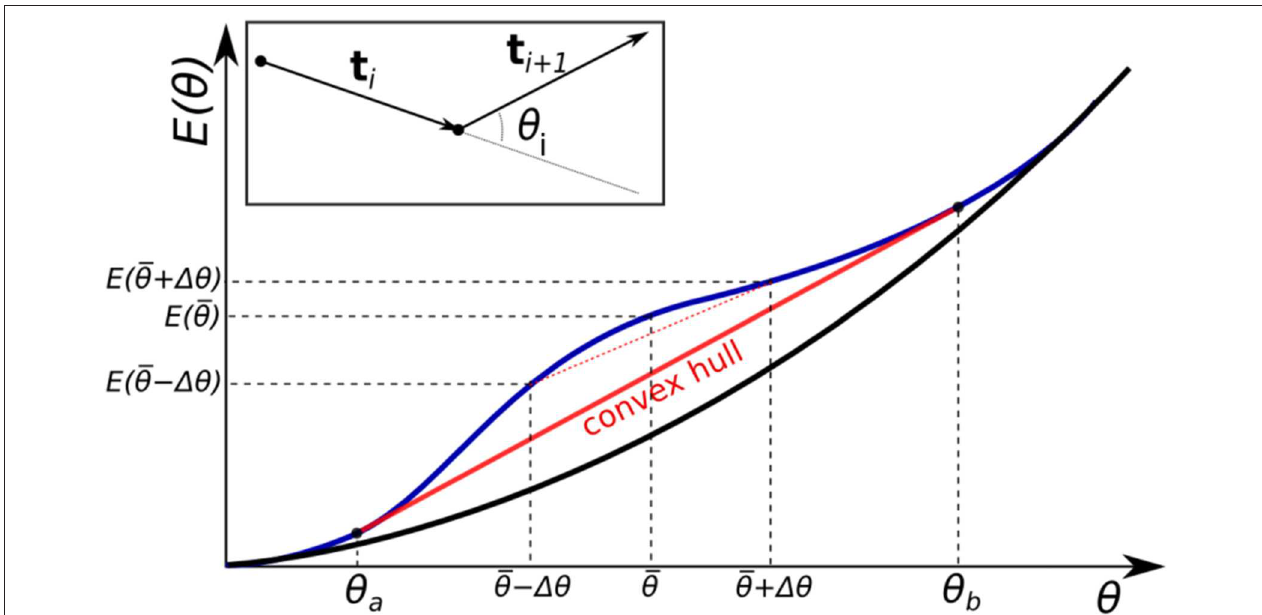
FIGURE 1 | Two different forms for a bending energy profile of a homopolymer. Shown is the (effective) bending energy per bending site E ( θ ). If the profile is purely convex down (black curve), the minimal energy conformations of the polymer is uniform bending (all sites are identically bent). If the function has a non-convex region (blue curve), non-uniform bending is more energetically favorable. In this case the total energy of the system follows the convex hull of the energy curve (red